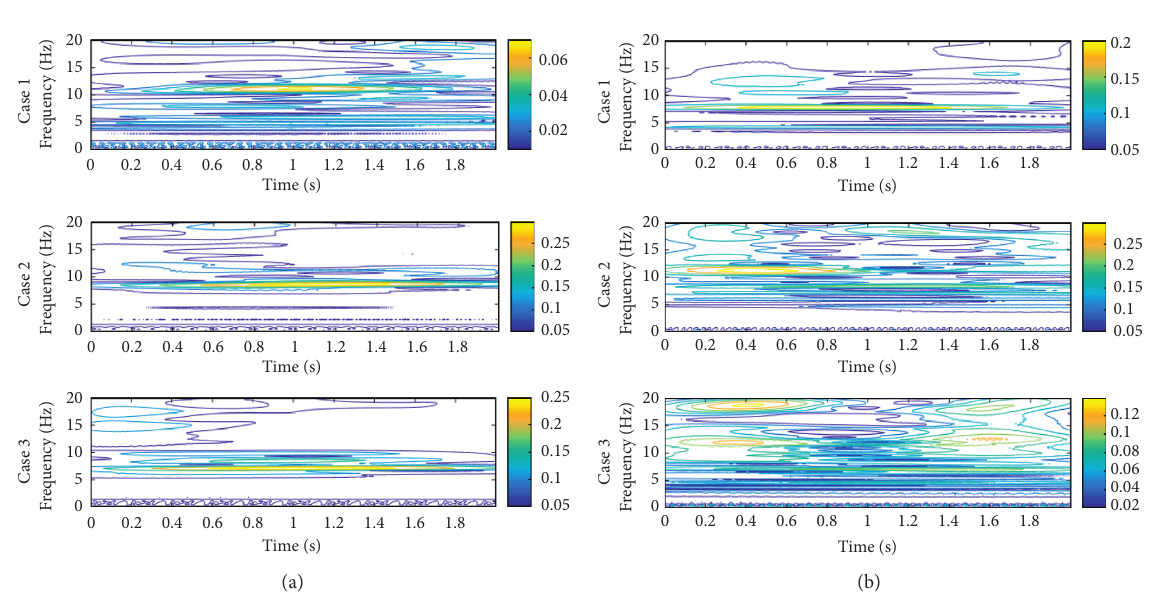
Figure 8: Time-frequency representation of motor and trailer bogie frames’ acceleration signals in respect of different cases: (a) motor bogie frame and (b) trailer bogie